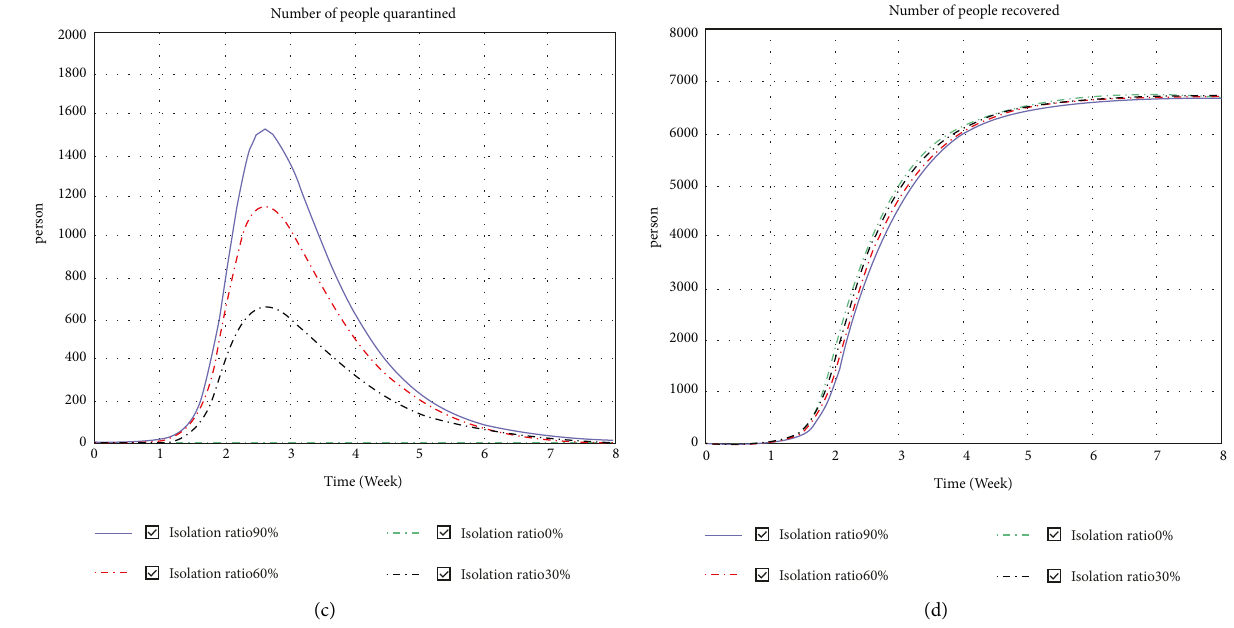
Figure 9: Simulation prediction results of different quarantine